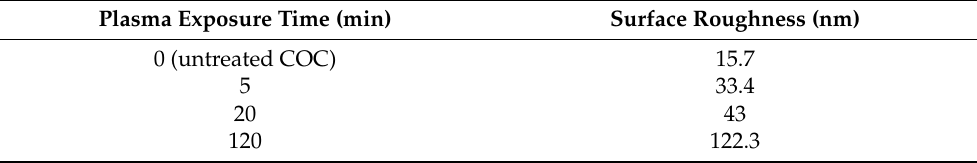
Table 1. Surface roughness of plasma treated COC at different plasma exposure times.